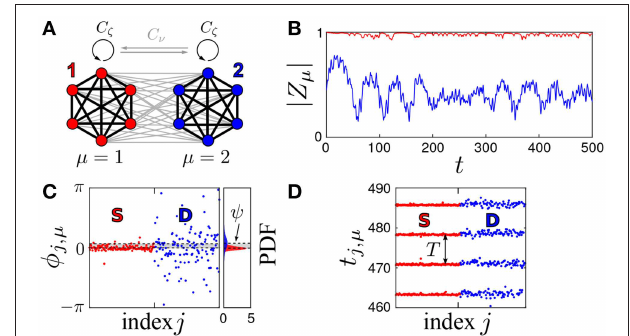
FIGURE 1 | (A) Chimera state in a network with M = 2 oscillator subpopulations and non-uniform coupling, simulated using Equation (1). (B) The time evolution of the order parameter, | Z µ ( t ) | , µ = 1,2, reflects the fluctuations driven by the coupling and the external field. Despite temporary deviations off the synchronization manifold | Z 1 | = 1, the system remains near the chimera state attractor. That is, chimera states appear robust to both coupling heterogeneity and additive noise. Considering the time-average of the order parameters, the state may be classified as a stable chimera. (C) Snapshot in time of the phases φ j , µ ( t ). The probability density distributions (PDF) of the phases reveal a phase shift between subpopulations 1 and 2, given by ψ : = arg ( Z 2 / Z 1 ), which remains on average constant in time, ψ = 0.26. (D) Times t ′ j , µ correspond to the Poincaré sections of the phases i.e., t ′ j , µ such that φ i ( t ′ j , µ ) = 0. The time period of collective oscillation is defined as T : = 1 /(cid:127) and (cid:127) : = hh d φ dt i t i j where h·i t and h·i j denote averages over time and oscillators, respectively. Parameters are: A = 0.275, β = 0.125, σ C = 0.01, σ ω = 0.01, σ 2 W =